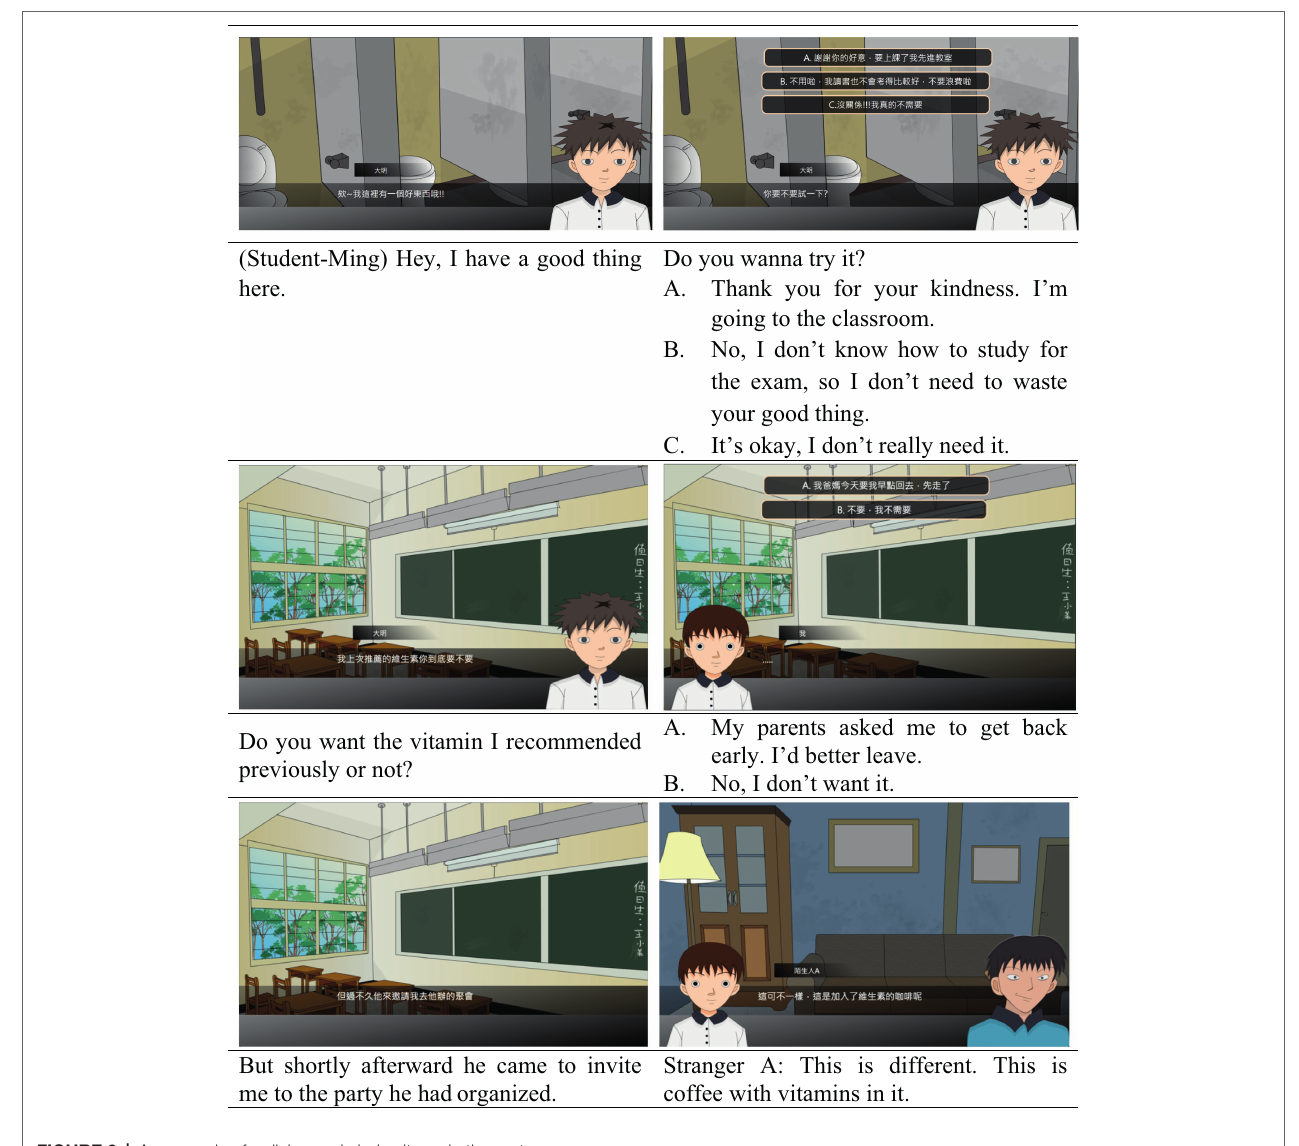
FIGURE 3 | An example of a dialog and choice items in the system.